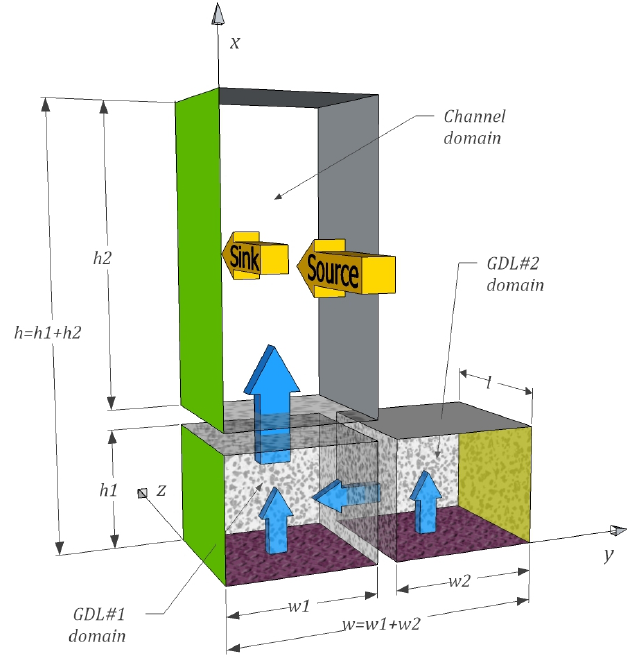
Figure 2. Detailed schematic of gas part comprising three computational domains. The top cuboid is the channel domain, bottom left cuboid GDL#1 domain and bottom right cuboid GDL#2 domain. The “Source” arrow represents the convective inflow of species from the channel domain of the previous upstream slice and the “Sink” arrow represents the outflow into the channel domain of the next downstream slice. Blue arrows represent the molar fluxes of water traversing the borders between domains that serve as boundary conditions for the individual solutions in domains. The ribbed purple surface represents the catalyst layer, i.e. , the MEA/GDL interface. At the grey surfaces, i.e. , the walls, and at the green and yellow surfaces, i.e. , the two symmetry planes, the boundary condition requires zero flux through the